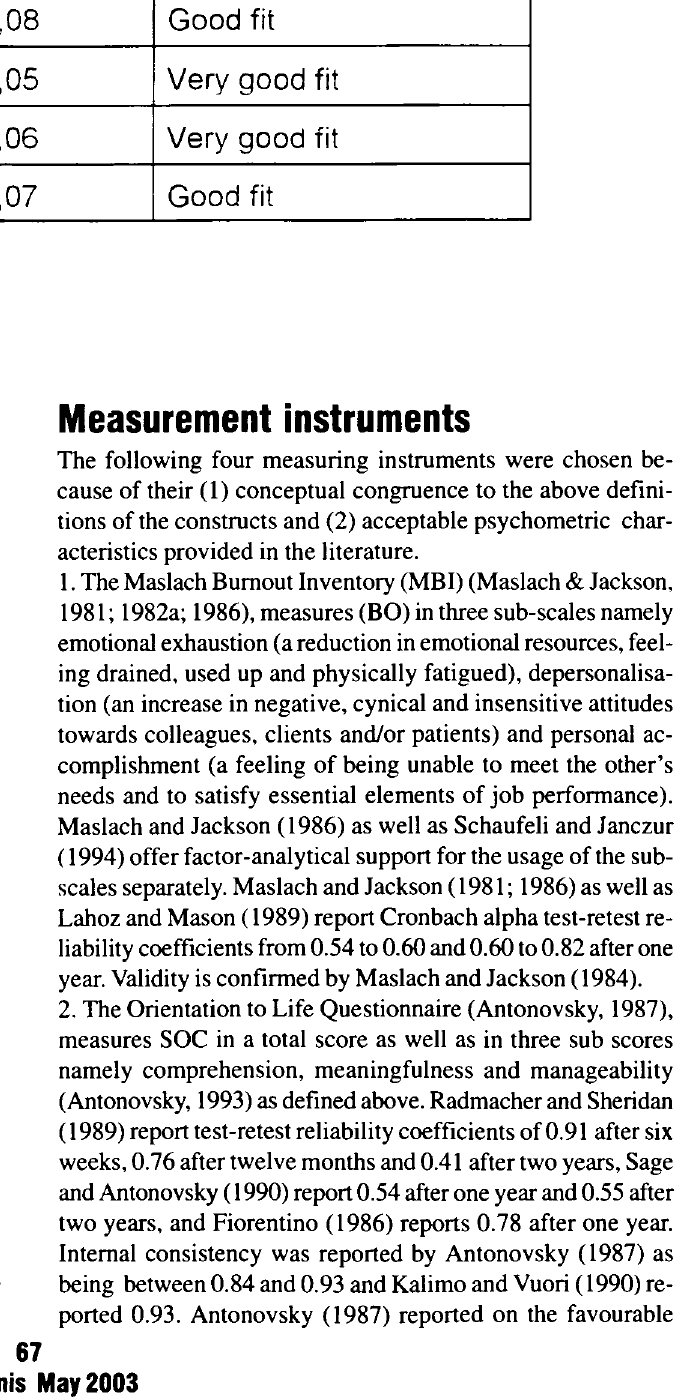
Steiger-Lind RMSEA index of fit for each of tlie questionnaires